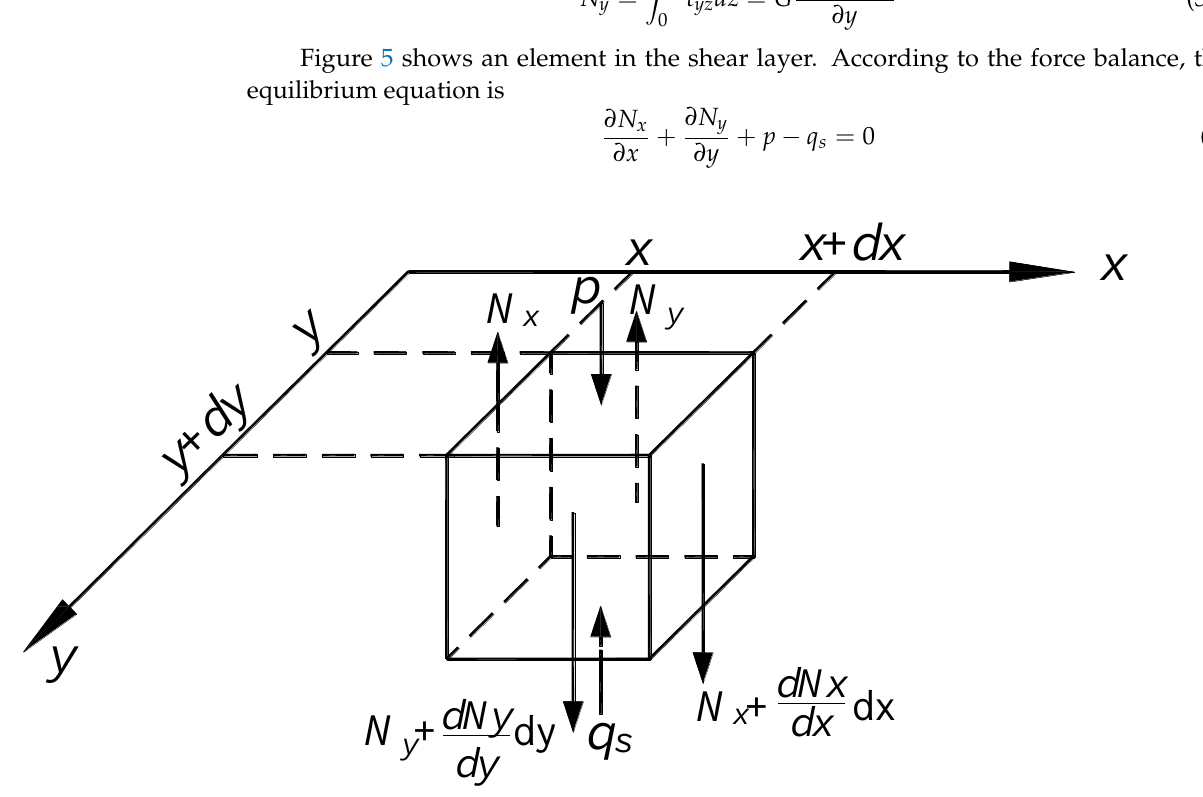
Figure 5. Vertical equilibrium of an element in the shear layer.